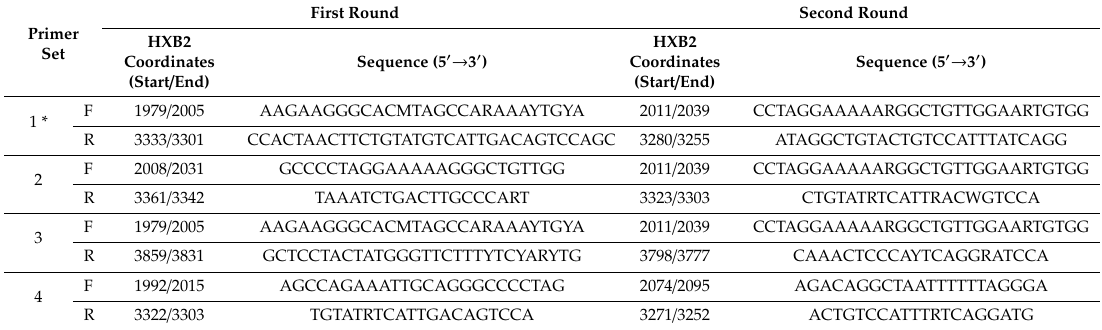
Table 1. Primers used for human immunodeficiency virus (HIV)-1 protease and reverse transcriptase (RT)